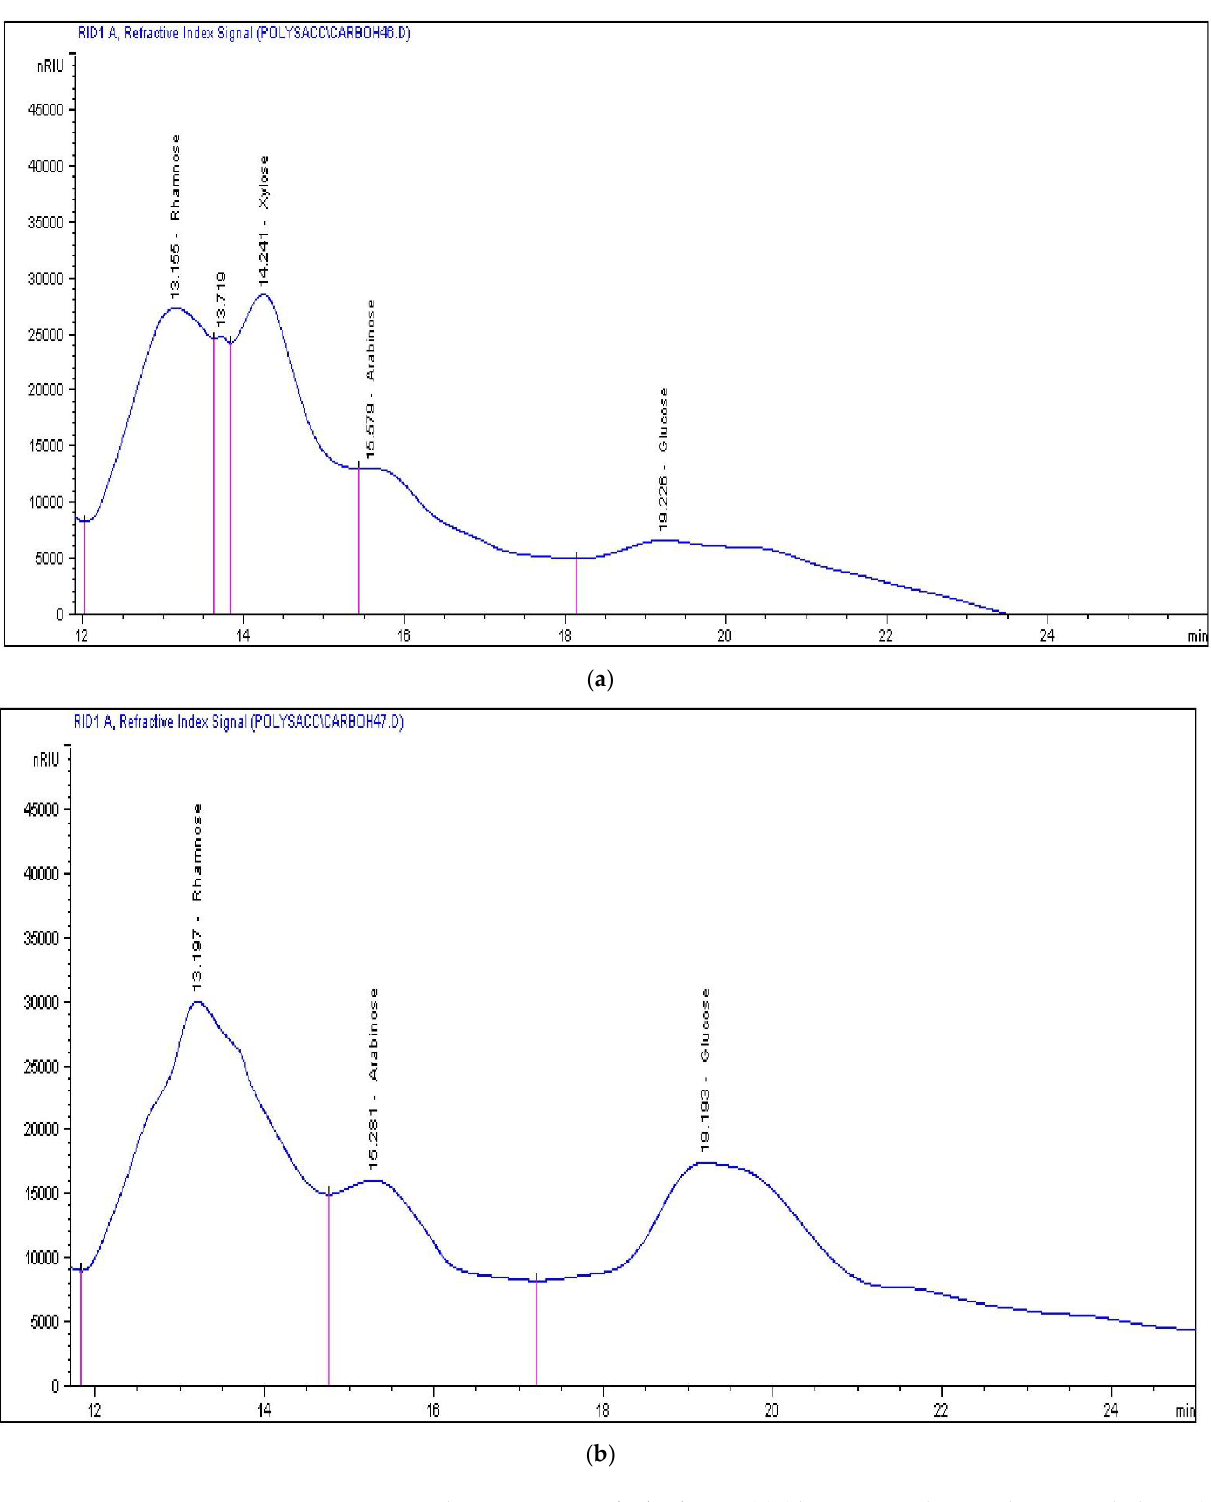
Figure 1. HPLC chromatograms of Ulva lactuca ( a ) (rhamnose, xylose, arabinose and glucose) and Ulva fasciata ( b ) (rhamnose, arabinose and glucose). X-axis: Retention times (min); Y-axis: Observed peak area (nRIU = the intensity of the refraction index signals ) .